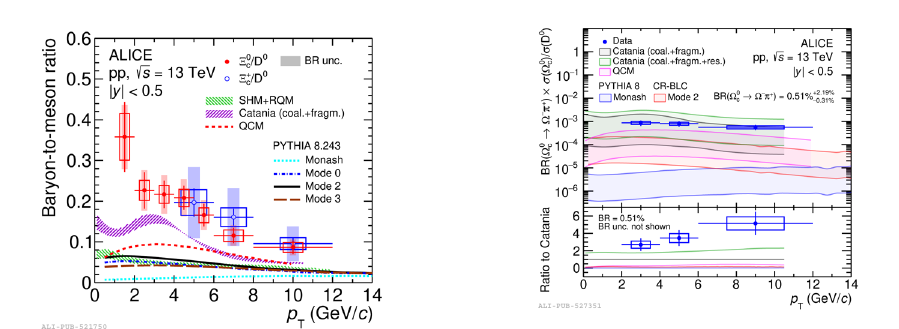
Figure 1. Left panel: Λ + c / D 0 as a function of p T in pp and p–Pb collisions at √ s = 5.02TeV . Right panel: Σ 0 , ++ c / D 0 ratio as a function of p T at √ s = 13TeV. Figure 2. Left panel: Ξ 0 , + c / D 0 as a function of p T in pp collisions at √ s = 13TeV. Right panel: BR / D 0 ratio as a function of p Ω 0 c